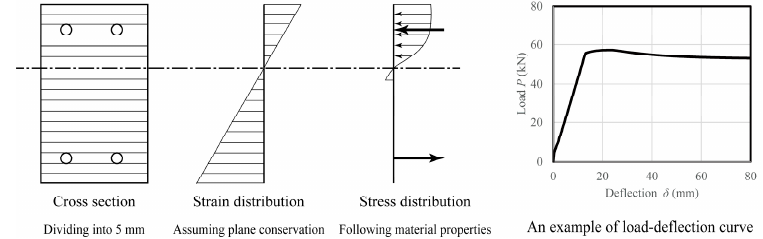
Figure 3. Calculation concept of the fiber